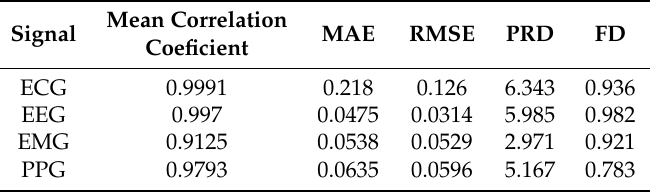
Table 3. Statistical Measure for Biomedical Signals.